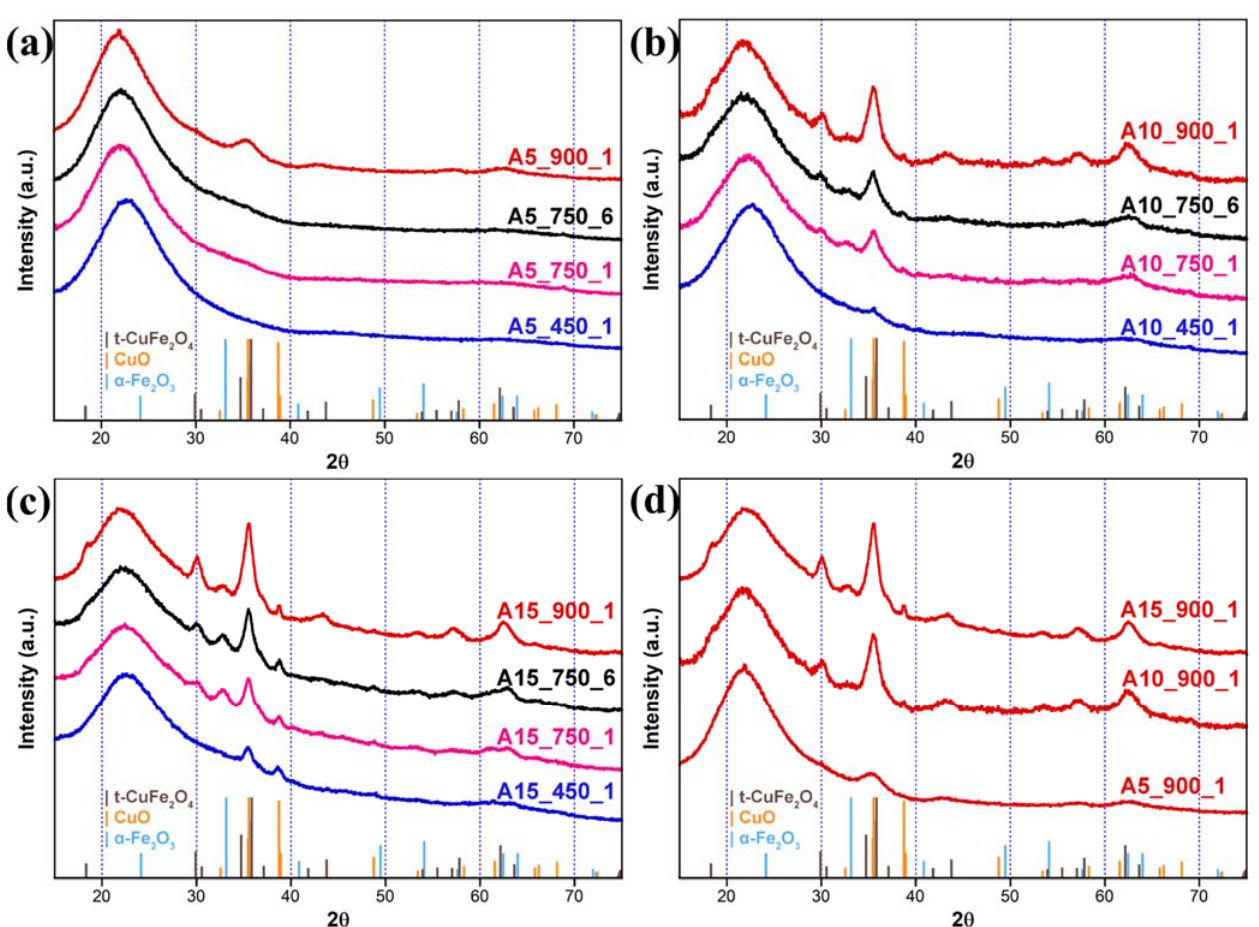
Figure 1. X ‐ ray diffraction (XRD) patterns of the aerogel nanocomposites with ( a ) 5 wt%; ( b ) 10 wt%; ( c ) 15 wt% loading of the dispersed nanophase, reported as a function of the calcination temperature; ( d ) comparison of the XRD patterns of the aerogel samples after thermal treatment at 900 °C, at different CuFe 2 O 4 loadings.